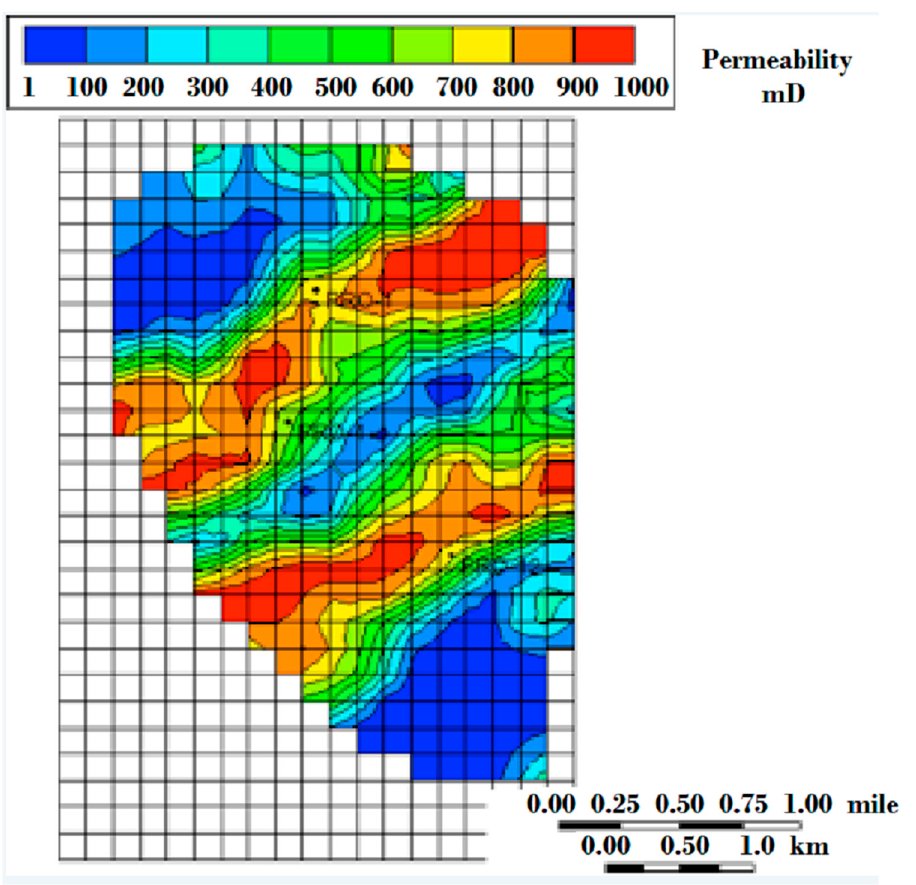
Figure 4. PUNQ-S3 top structure map and reservoir well locations [43].